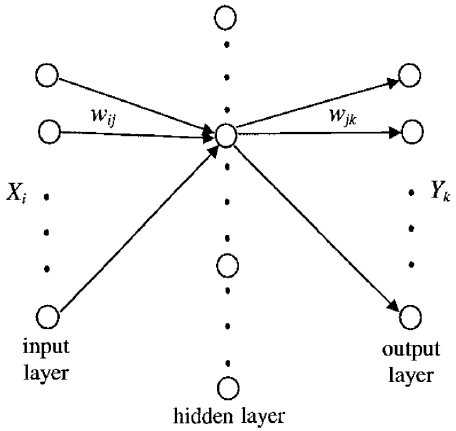
Figure 8. Hong’s Neutral Network (reprinted from